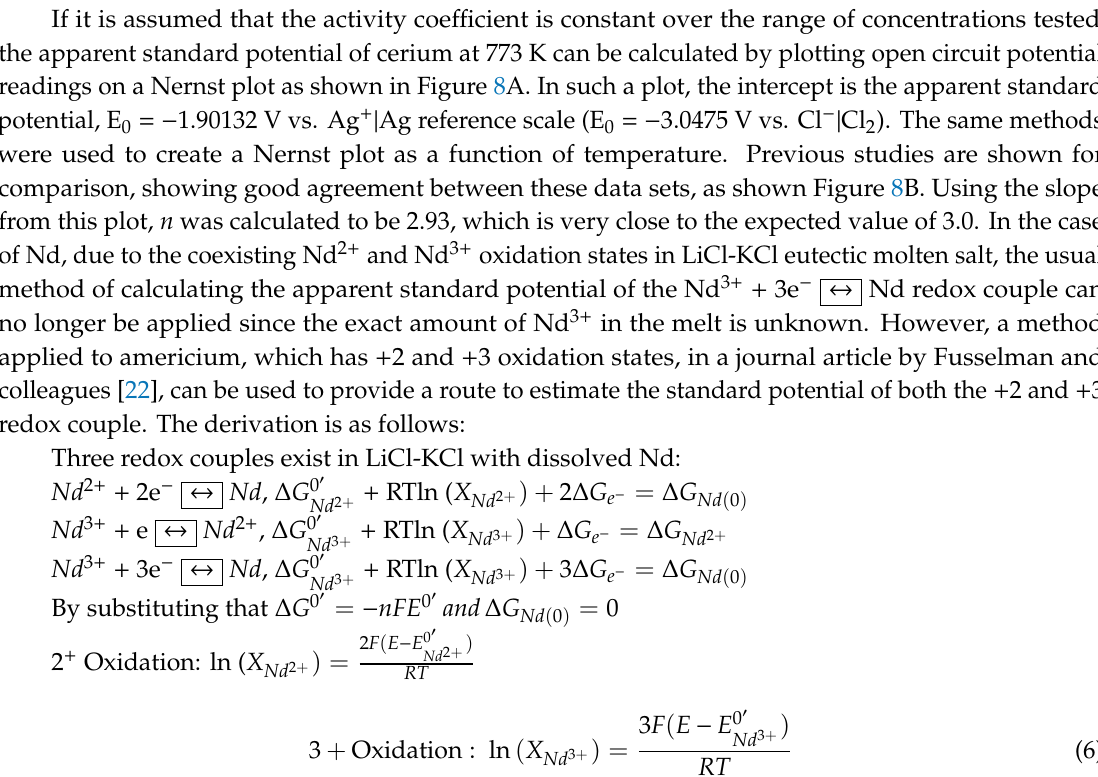
Figure 7. ( A ) Linear relationship of the logarithm of NdCl 3 diffusion coefficient vs. the reciprocal of absolute temperature. ( B ) Activation energy as a function of NdCl 3 concentration.